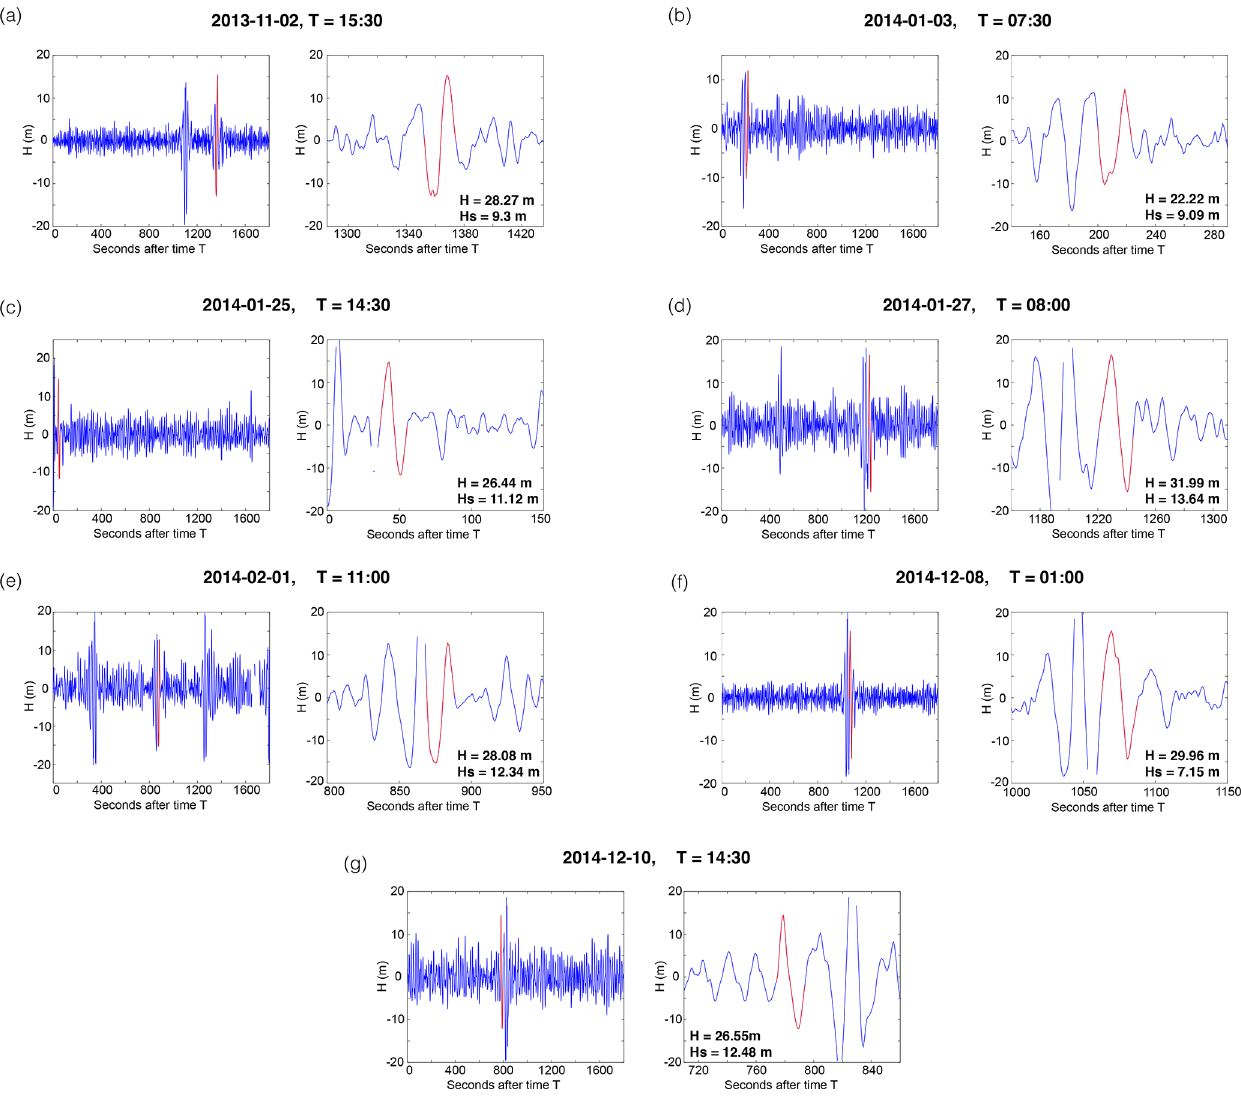
Figure 14. Large rogue waves recorded at Killard ESB buoy. Wave height recordings for the 30min duration when wave occurred (left column) and zoomed in around the time of event (right column). The waves are highlighted in red with wave height ( H ) and significant wave height ( H s ) inset into zoomed figure. (a) 2 November 2013, 15:30. (b) 3 January 2014, 07:30. (c) 25 January 2014, 14:30. (d) 27 Novem- ber 2014, 08:00. (e) 1 February 2014, 11:00. (f) 8 December 2014, 01:00. (g) 10 December 2014,